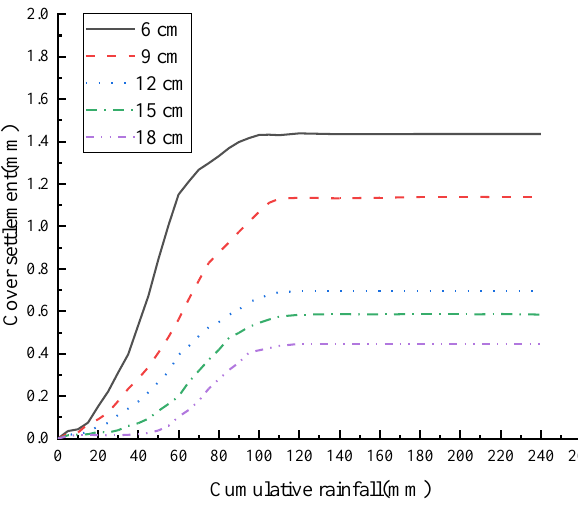
Figure 5: 6 cm (1.44 mm) > 9 cm (1.13 mm) > 12 cm (0.69 mm) > 15 cm (0.58 mm) > 18 cm